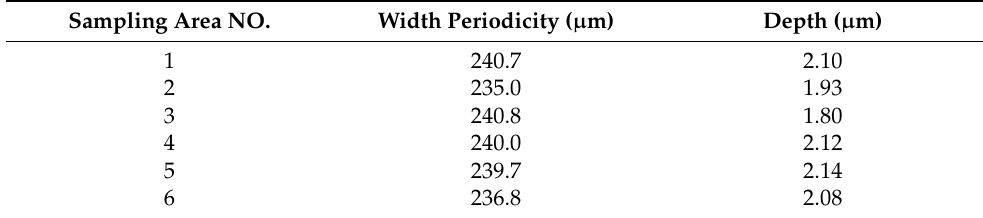
Table 3. The width periodicity and depth of fabricated array